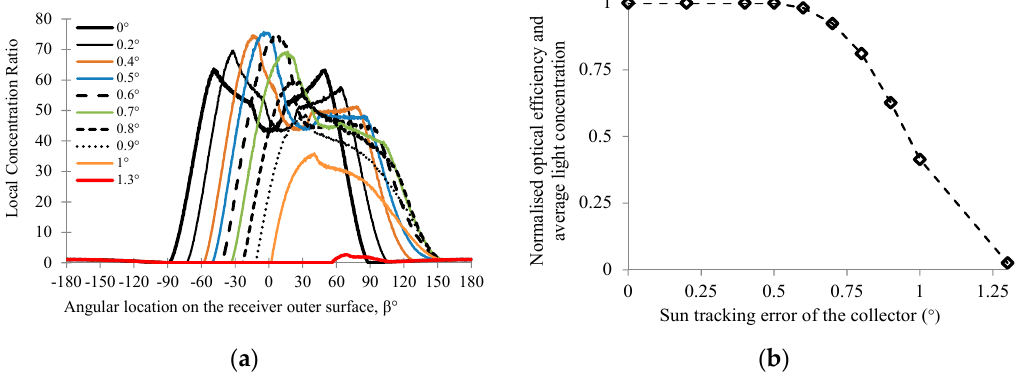
Figure 14. Effect of tracking error (°) on ( a ) LCR profile of the receiver and ( b ) on the η opt and C avg of the collector.